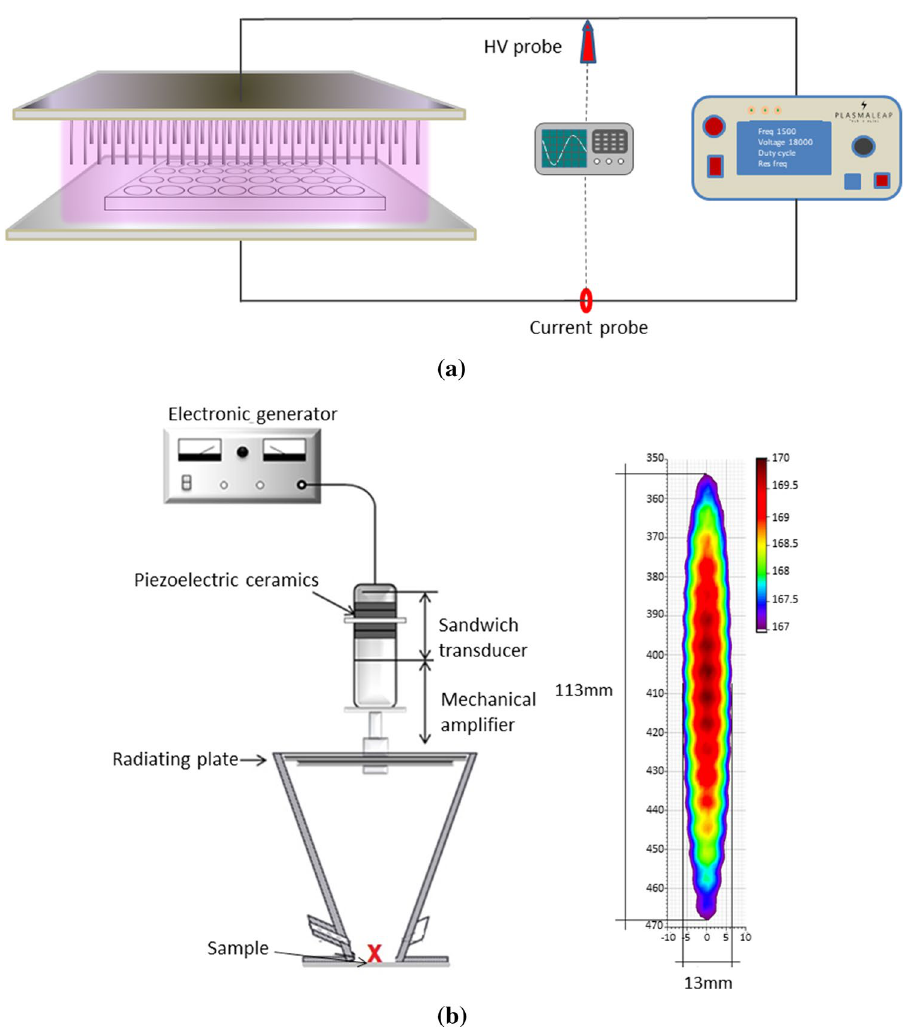
Figure 8. Schematic diagram of bacterial coupons treated with ( a ) atmospheric air plasma or ( b ) acoustic airborne ultrasound system and its intensity